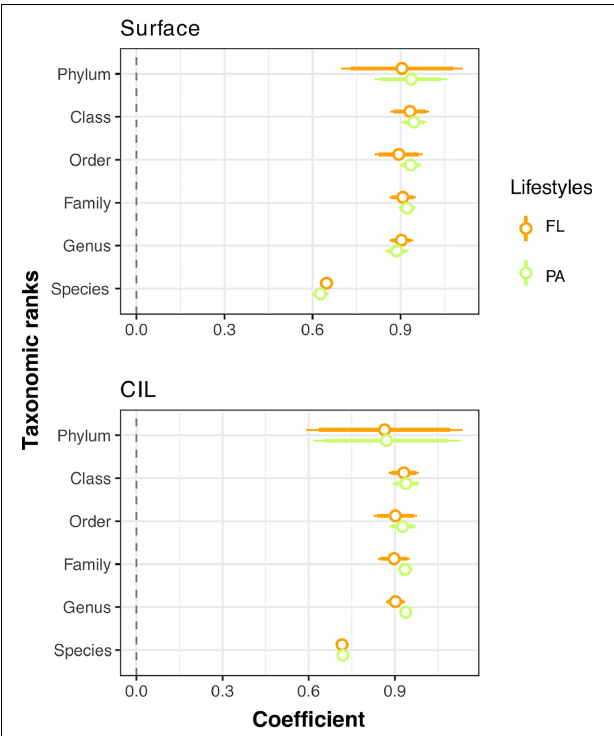
FIGURE 5 | Coefficient plots of the Spearman ranks explaining the mean relative abundance and occupancy relationships (AORs) across taxonomic ranks for free-living (FL, orange) and particle-attached (PA, green) bacterial communities at two depths: the surface and the cold intermediate layer (CIL). The coefficients and their intervals are reported as one and two standard errors of the coefficient. A positive ( > 0) coefficient indicates a positive correlation of the mean relative abundance of individual taxa with the number of sampled sites at which they occurred ( P < 0.001 in all cases after corrections for multiple testing). The coefficients and P -values of the significance for each Spearman’s rank correlation are given in Supplementary Table 6